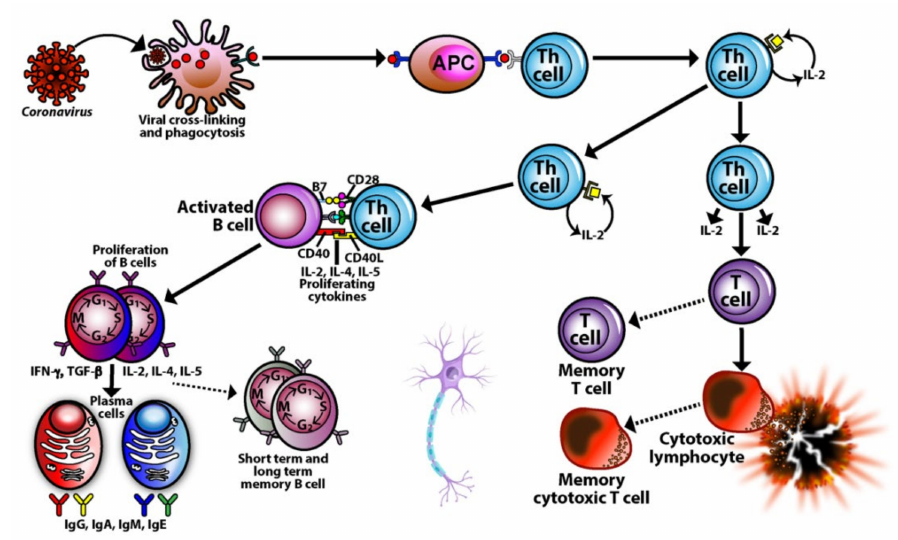
Figure 3. The interactive network of the immune system. The immune system is a complex network of different kinds of cells that must work together and combine in just the right numbers, ratios, and percentages to protect the host from